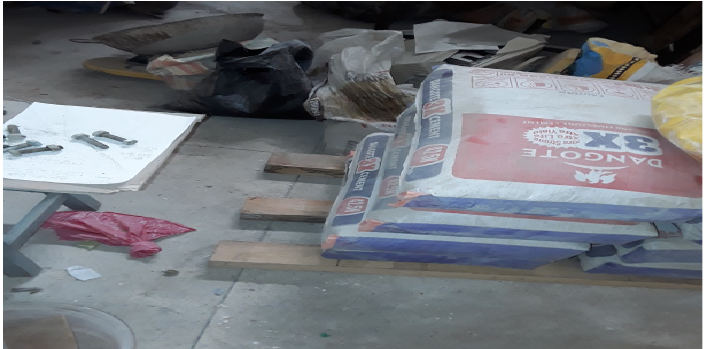
Figure 3. Portland cement utilised for this study.